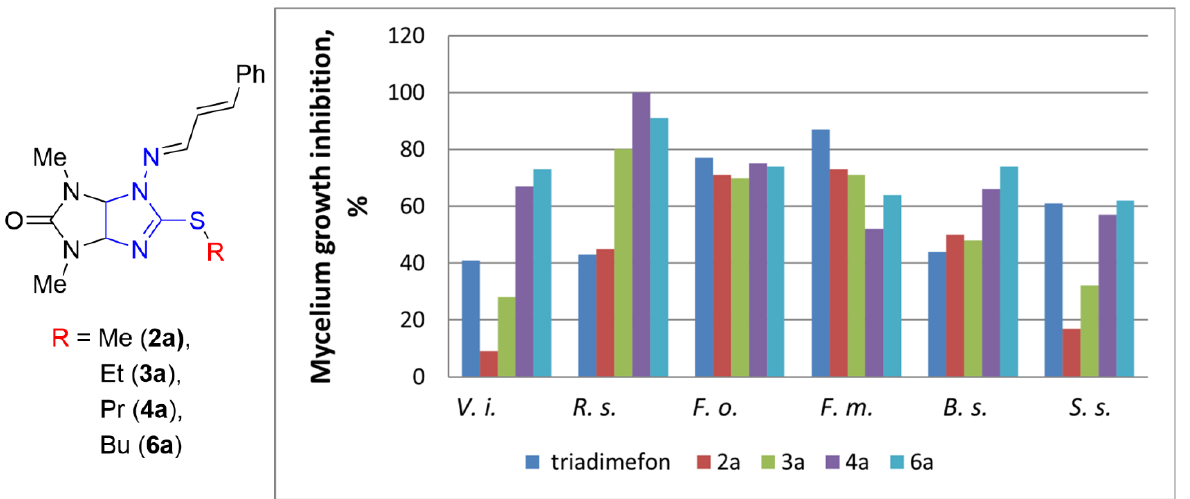
Figure 2 . Venturia inaequalis ( V. i .), Rhizoctonia solani ( R. s .), Fusarium oxysporum ( F. o .), Fusarium moniliforme ( F. m .), Bipolaris sorokiniana ( B. s .), and Sclerotinia sclerotiorum ( S. s .) mycelium growth inhibition under treatment with triadimefon and S-alkyl derivatives 2a 20 , 3a 20 , 4a, and 6a .